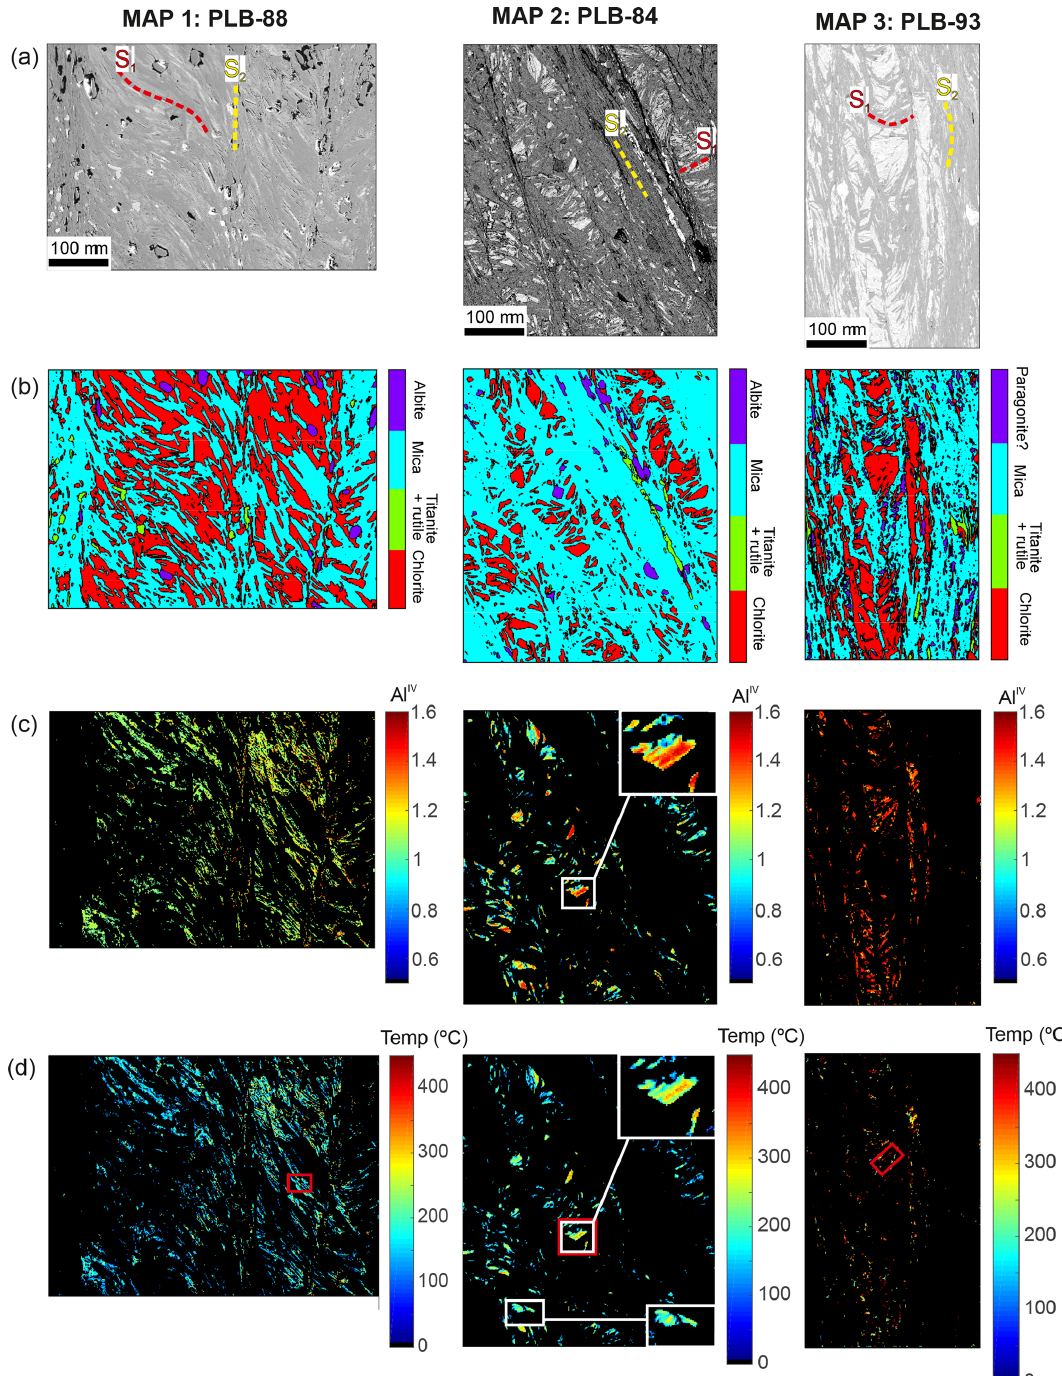
Figure 4. X-ray maps of the three selected samples analyzed by EPMA and processed with XMapTools. The samples belong to the lower for- mations of the Pulo do Lobo domain (sample PLB-88: Ribeira de Limas Formation; samples PLB-84 and PLB-93: Pulo do Lobo Formation; the latter (PLB-93) is close to early Carboniferous igneous intrusions). (a) EPMA BSE photographs. (b) Mineral maps. (c) Al IV content map in chlorites, which increases with temperature. The white square highlights the zonation of a chlorite grain from core to rim. (d) Temperature maps of chlorite using the Lanari et al. (2014a) geothermometer assuming all iron as ferrous. White squares show selected areas illustrating higher-temperature chlorite cores. Red squares show the selected areas (representative of S 1 foliation) used for the chlorite–quartz–water geothermometric calculations shown in Fig.